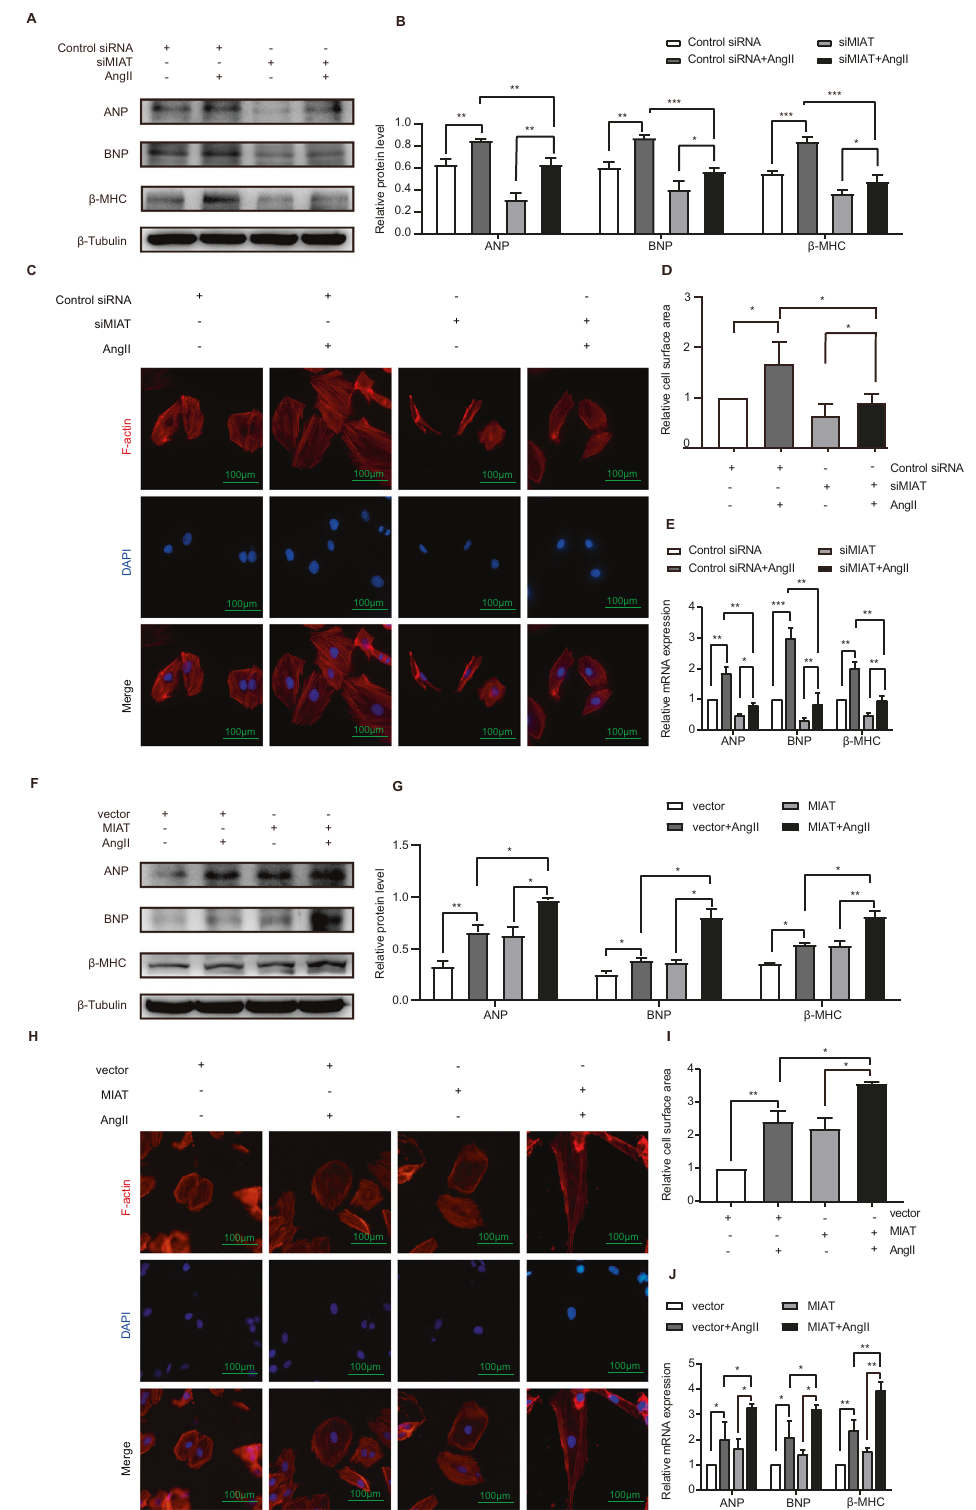
Fig. 2 MIAT mediated AngII-induced hypertrophy. H9c2 cells transfected with control siRNA or MIAT siRNA ( A – E ). A, B Western blot and the relative protein levels of ANP, BNP, and β -MHC. C Phalloidin staining. F-actin were stained with fl uorescent phalloidin (red), and the nuclei were stained with DAPI (blue). Scale bar: 100 um. D Relative cell surface area measured by phalloidin staining. E RT-qPCR of the relative mRNA expression levels of ANP, BNP, and β -MHC. H9c2 cells transfected with vector empty or MIAT plasmid ( F – J ). F, G Western blot analysis and the relative protein level of ANP, BNP, and β -MHC. H Phalloidin staining. F-actin in the H9c2 cells were stained with fl uorescent phalloidin (red), and the nuclei were stained with DAPI (blue). Scale bar: 100 um. I Relative cell surface area measured by phalloidin staining. J RT-qPCR of the relative mRNA expression levels of ANP, BNP, and β -MHC. All data were expressed as mean ± SD ( n = 3). ∗∗∗ p < 0.001; ∗∗ p < 0.01; ∗ p < 0.05.